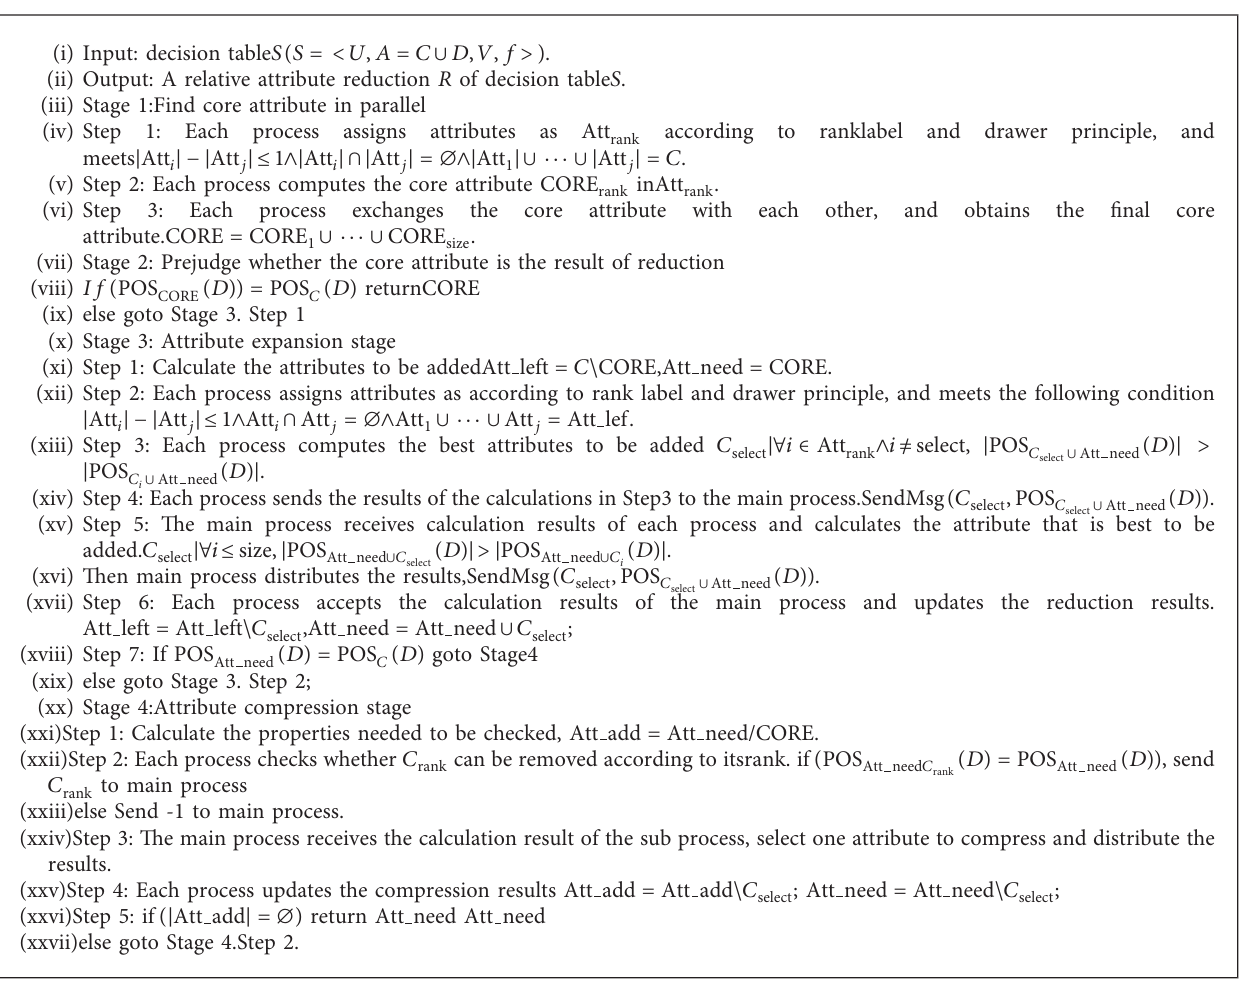
A LGORITHM 3: Parallel attribute reduction